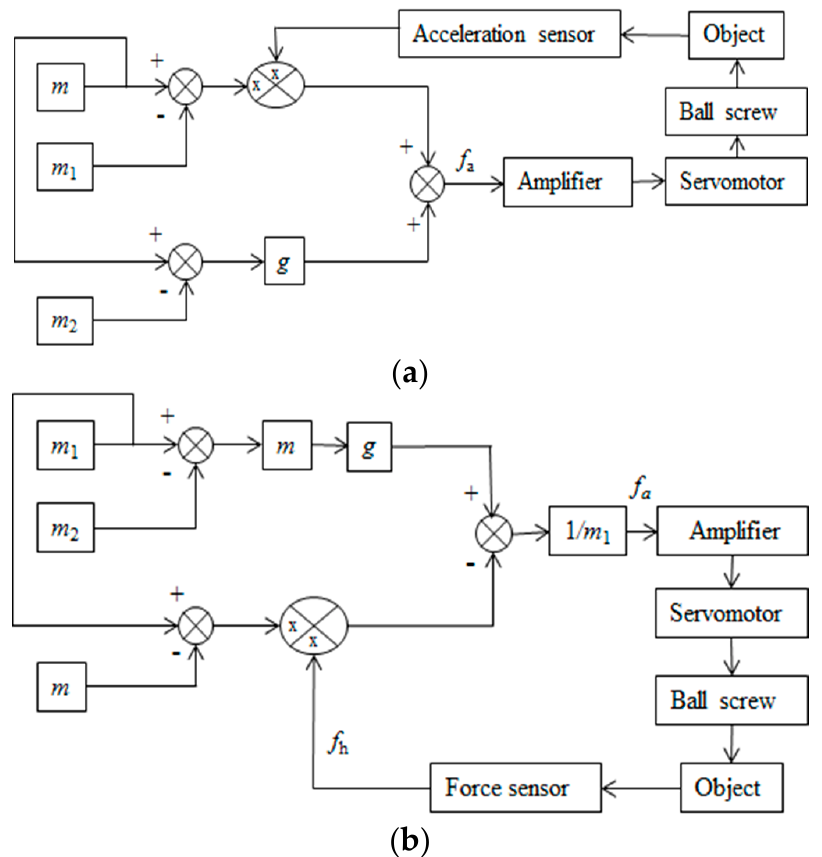
Figure 6. The force control schemes/methods: ( a ) force control scheme/method 1 (a force control scheme, but it is force sensorless); ( b ) force control scheme/method 2 (uses a force sensor that measures a human’s load force).